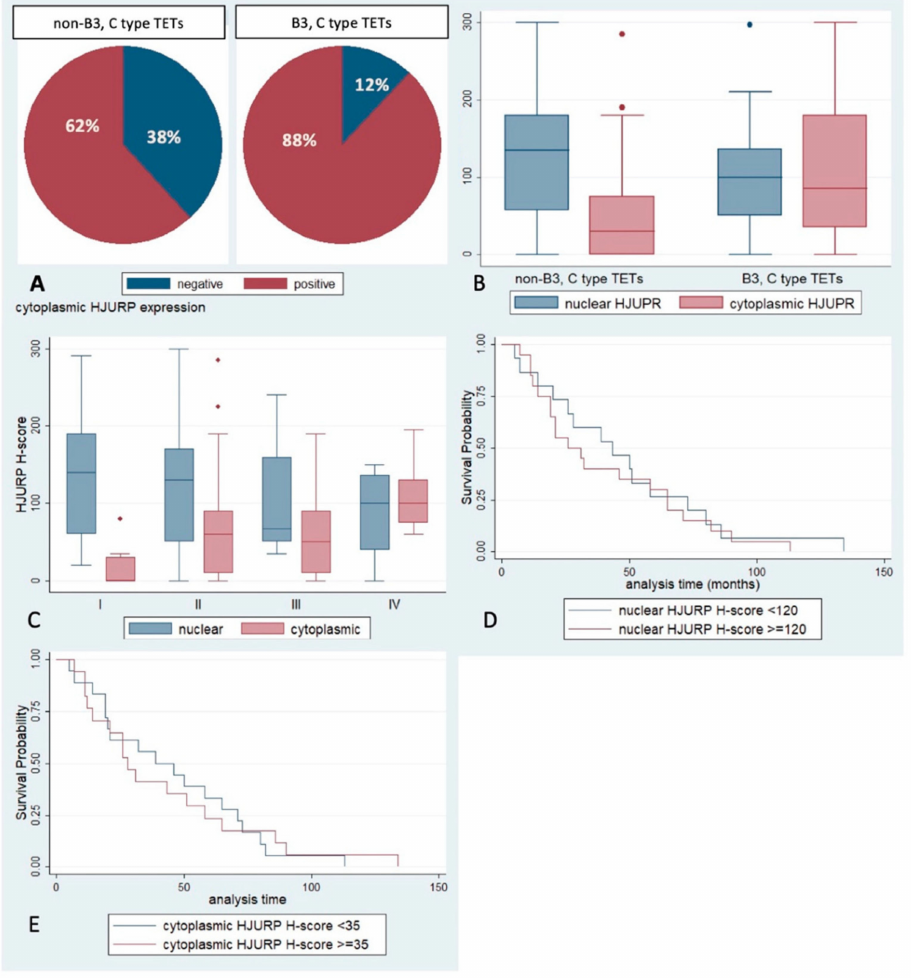
Figure 4. ( A ) Positivity rate of cytoplasmic HJURP in epithelial cells according to the WHO his- tological subtype (Fischer’s exact test, p = 0.02). ( B ) Schematic representation of the associations between HJURP H-score and WHO subtype (Mann–Whitney U test, p < 0.001 for cytoplasmic and p > 0.10 for nuclear). ( C ) HJURP nuclear and cytoplasmic H-score according to Masaoka–Koga stage (Mann–Whitney U test, p < 0.01 for cytoplasmic, p > 0.10 for nuclear). ( D , E ) Kaplan–Meier survival rates according to nuclear ( D ) and cytoplasmic ( E ) HJURP H-score (log-rank test, p > 0.10 for both associations). Small diamonds in ( B , C ) correspond to